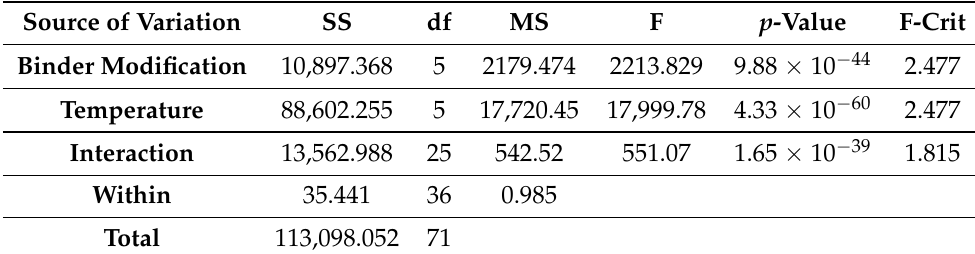
Table 8. Two-way ANOVA testing of the rutting parameters versus temperature. Source of